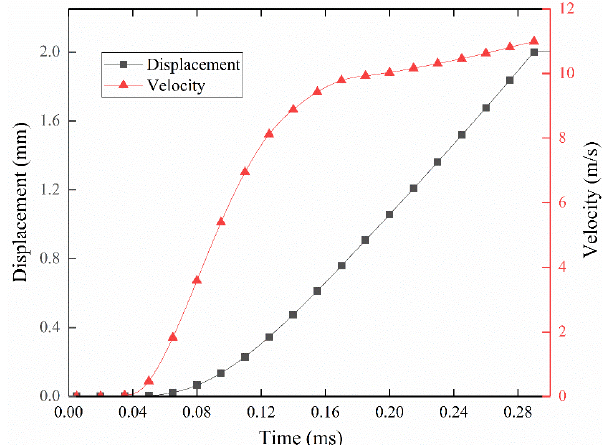
Figure 15. Displacement and velocity of the valve spool.